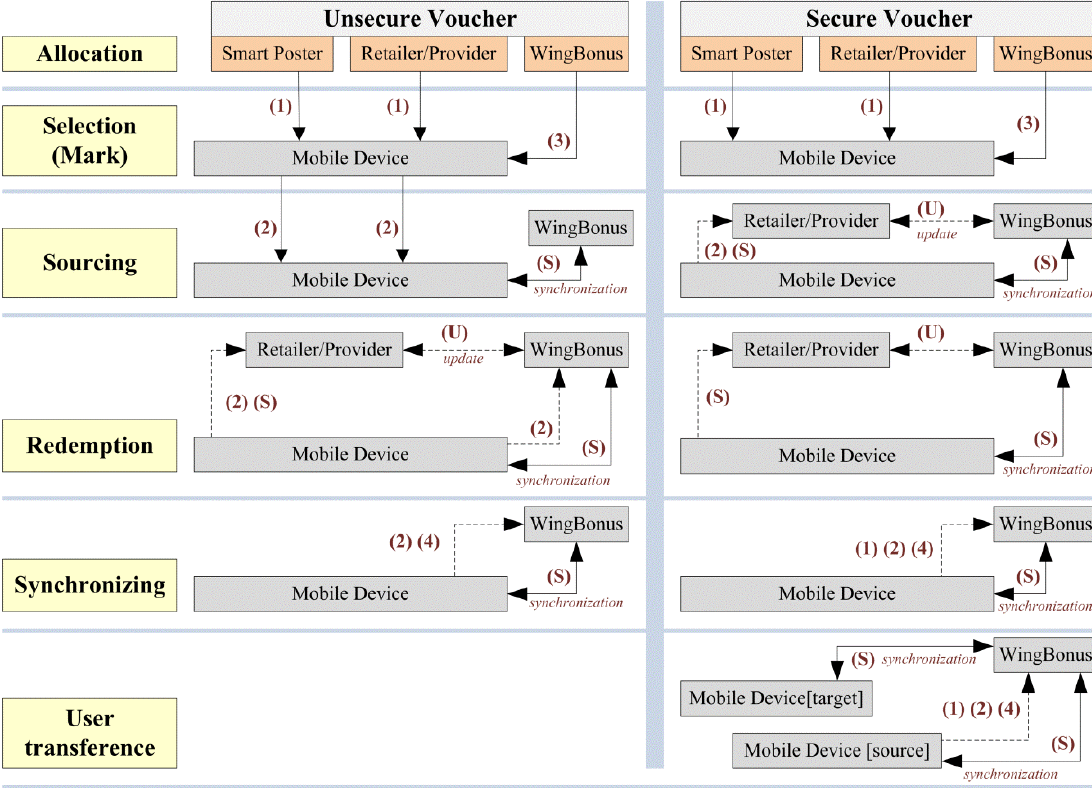
Figure 3. Flow of information between the system actors for secure and unsecure